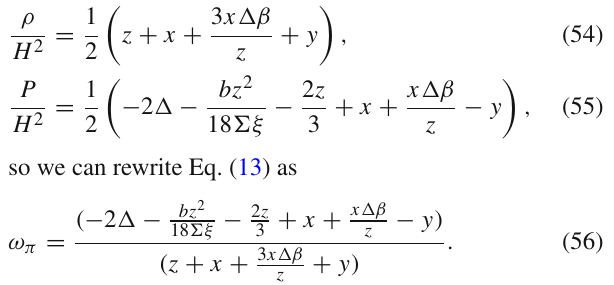
Fig. 6 A graph showing r ( N ) , q ( N ) and s ( N ) for ξ = 0 . 2, α = 0 . 1 and b = 2